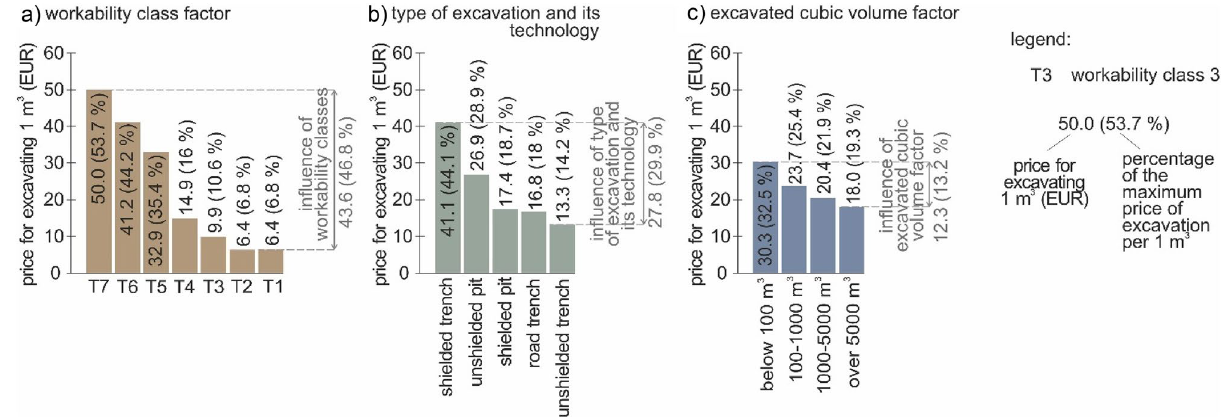
Figure 8. Graphs of the influence of the different earthwork factors on the price of 1 m 3 earthwork (evaluation approach—study 1); ( a ) workability class factor; ( b ) type of excavation and its technology; ( c ) excavated cubic volume